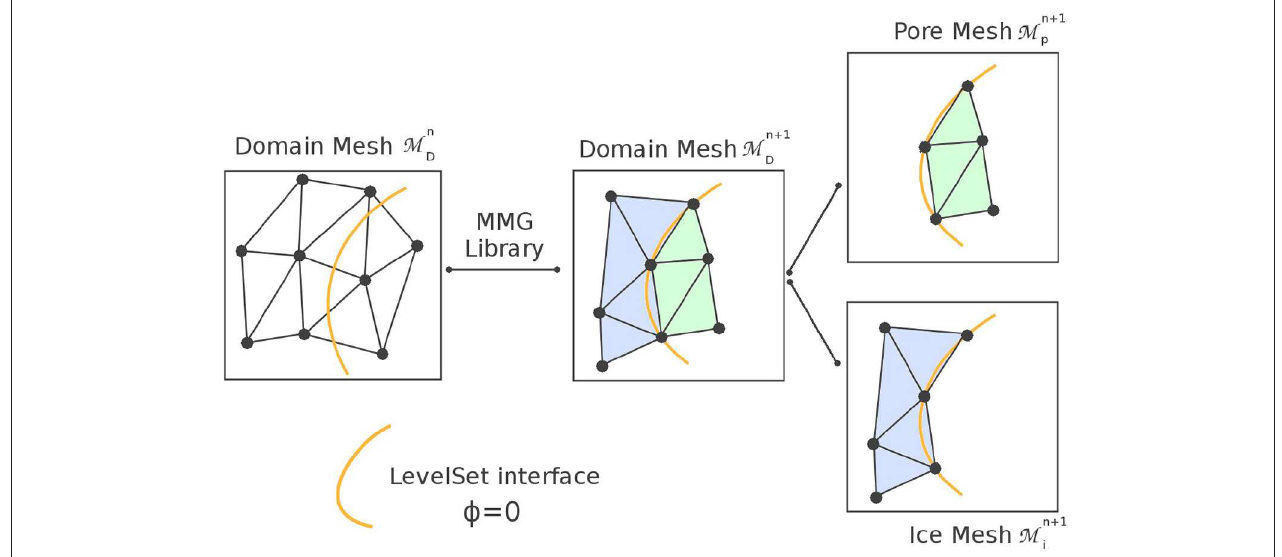
FIGURE 3 | Mesh adaptation of the domain following the LS function. The submeshes of the ice and pore phases M i , and M p are also produced during mesh adaptation.